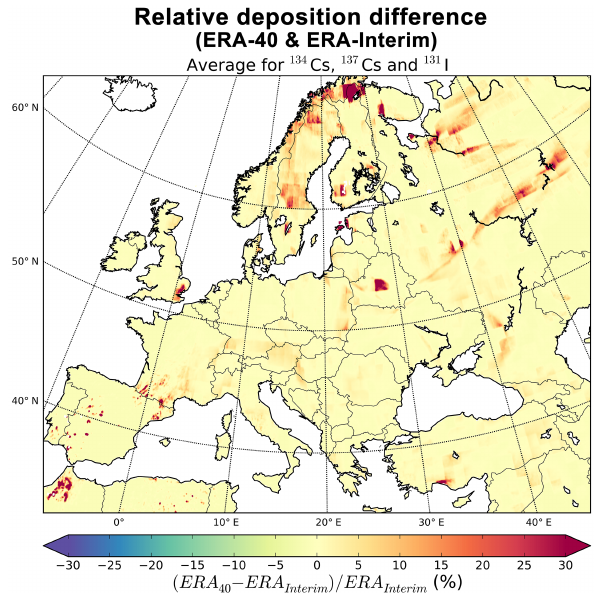
Figure 4. Percentage (%) deposition difference between the ERA-40 and ERA-Interim data sets, i.e., (ERA 40 – ERA Interim ) / ERA Interim in FLEXPART. The relative difference is an average for the radionuclides 134 Cs, 137 Cs and 131